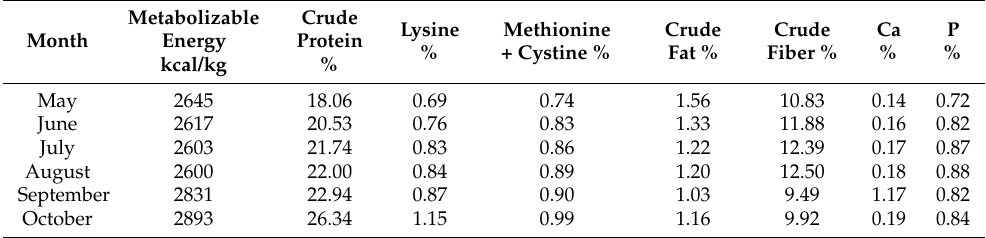
Table 1. Nutritional features of the supplemental feed provided in fishery, throughout May-October, 2010–2012.